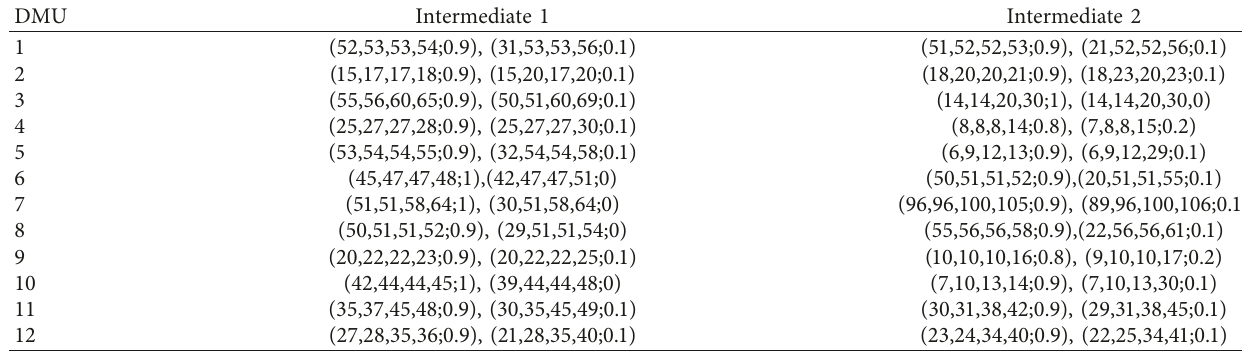
Table 2: Trapezoidal intuitionistic fuzzy intermediate products of the 12 DMUs.